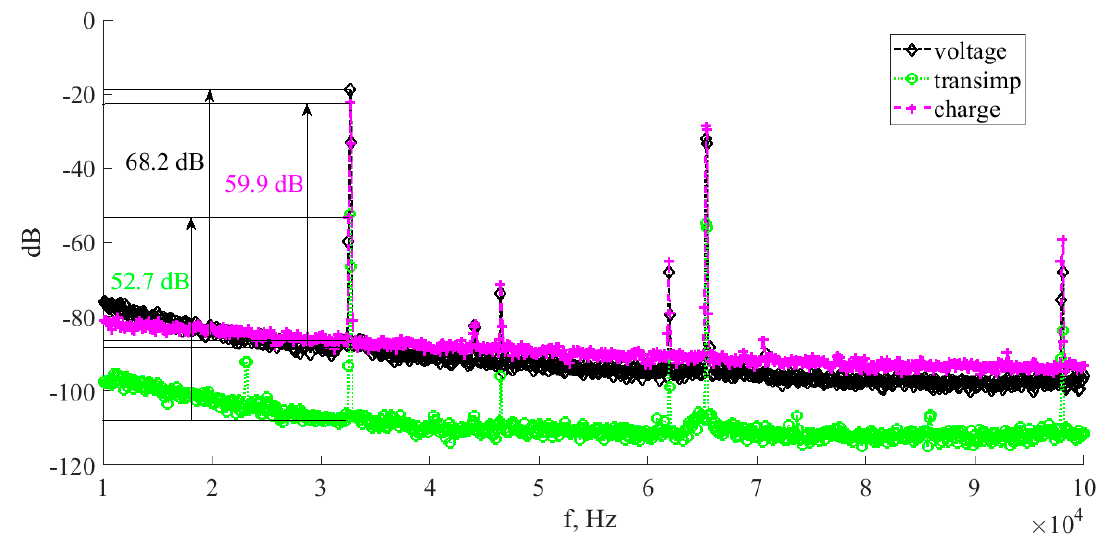
Figure 12. Average spectra obtained for the voltage, charge and transimpedance topologies. The SNR values in the neighborhood of the fs frequency are marked.